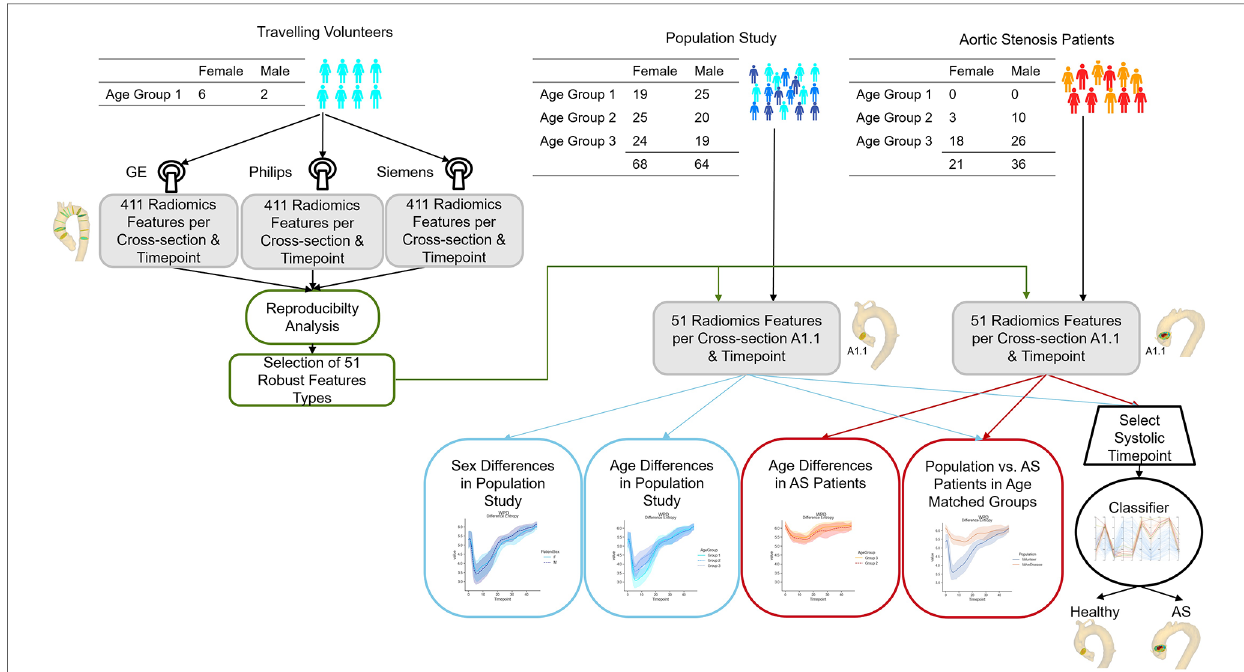
FIGURE 1 Flow chart of the presented study. Image data from eight volunteers acquired with GE, Philips and Siemens scanners are used to assess the reproducibility of 411 radiomics features extracted on twelve imaging planes across the thoracic aorta throughout the cardiac cycle. The 51 most robust features are extracted for age- and sex- strati fi ed cohorts of aortic stenosis patients and subjects without valve diseases for comparison. Age-matched cohorts are used to assess whether differences in fl ow pro fi le are identi fi able in the radiomics signatures. Finally, a classi fi er to differentiate healthy subjects from aortic stenosis patients is trained on the radiomics features of a cross-section in the ascending aorta (A1.1) for a peak systolic timeframe.